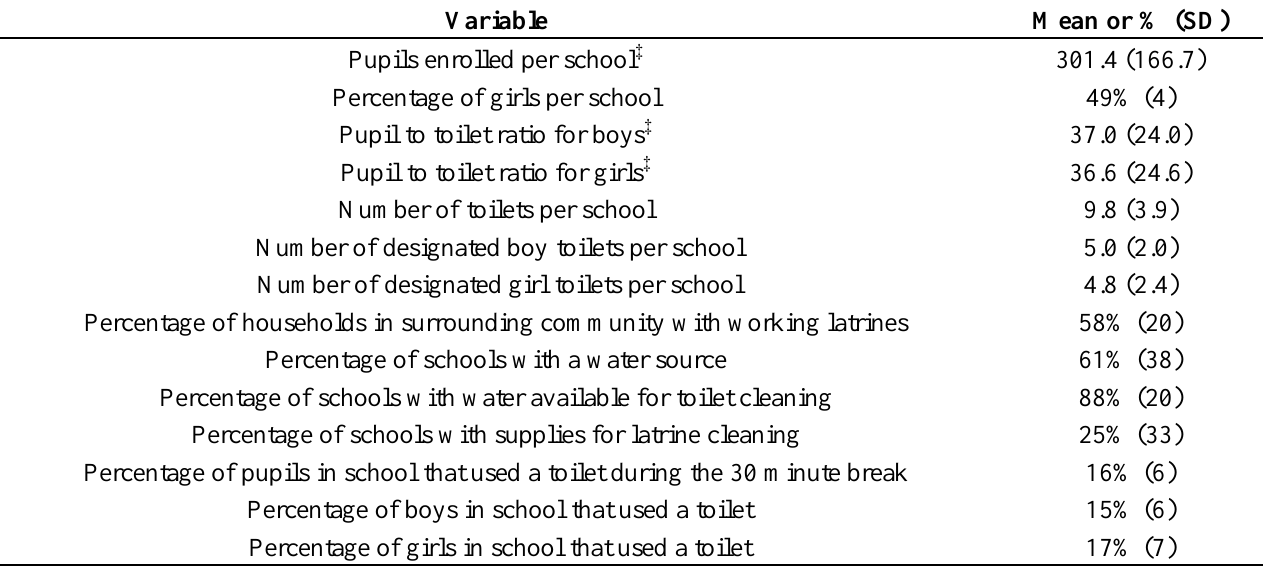
Table 1. School demographics ( N = 60 schools), aggregating 5 follow-up measures.